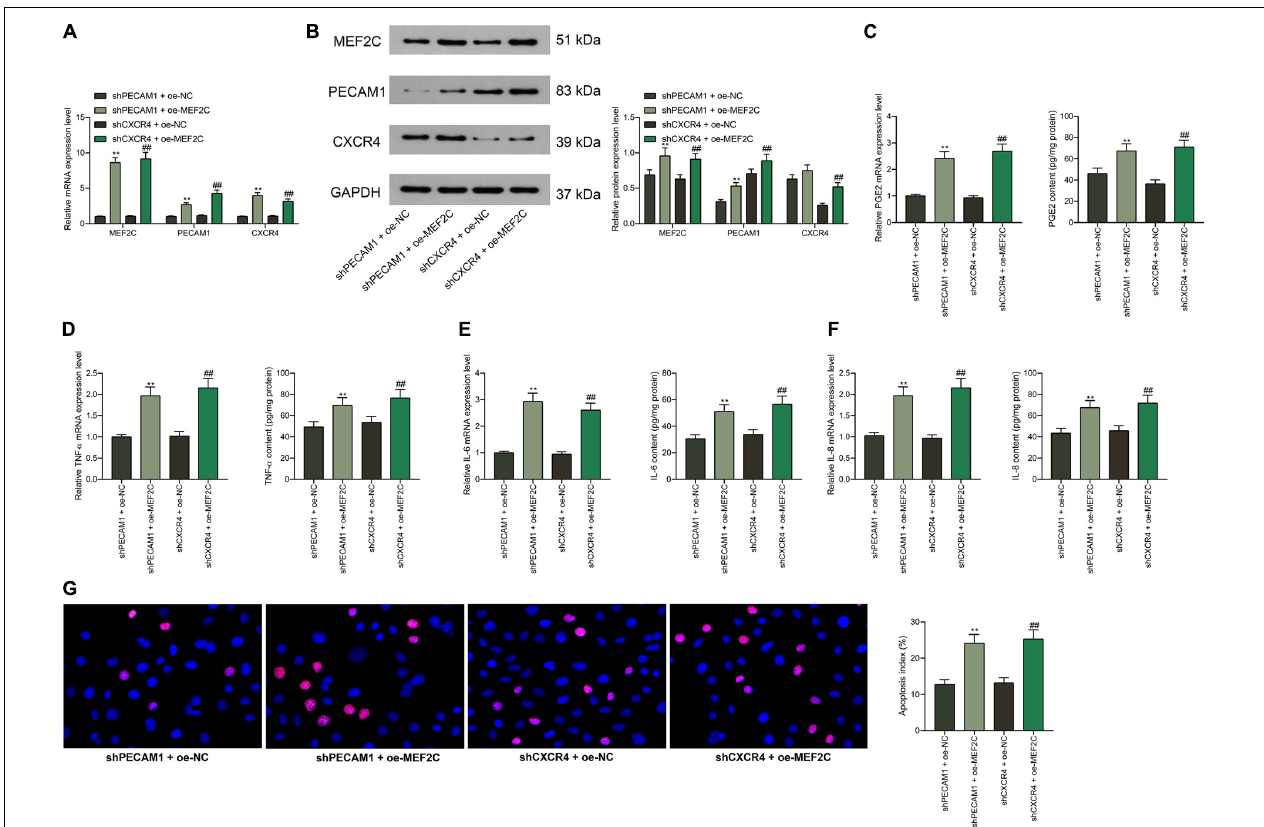
FIGURE 7 | Overexpression of MEF2C reverses the functions of shPECAM1 and shCXCR4 in cells. (A,B) MEF2C overexpression vector was further administrated into HDPFs in the presence of shPECAM1 and shCXCR4. (A,B) mRNA and protein expression of MEF2C, PECAM1, and CXCR4 in cells determined by RT-qPCR and western blot analysis, respectively. (C–F) Levels of PGE2, TNF- α , IL-6, and IL-8 in cells determined by RT-qPCR and ELISA kits, respectively. (G) apoptosis of HDPFs determined by TUNEL assay. Data were collected from three individual experiments and expressed as mean ± SD. Data were analyzed by one-way (C–G) or two-way ANOVA (A,B) followed by Tukey’s multiple comparison test. ** p < 0.01 vs. shPECAM1 + oe-NC; ## p < 0.01 vs. shCXCR4 +